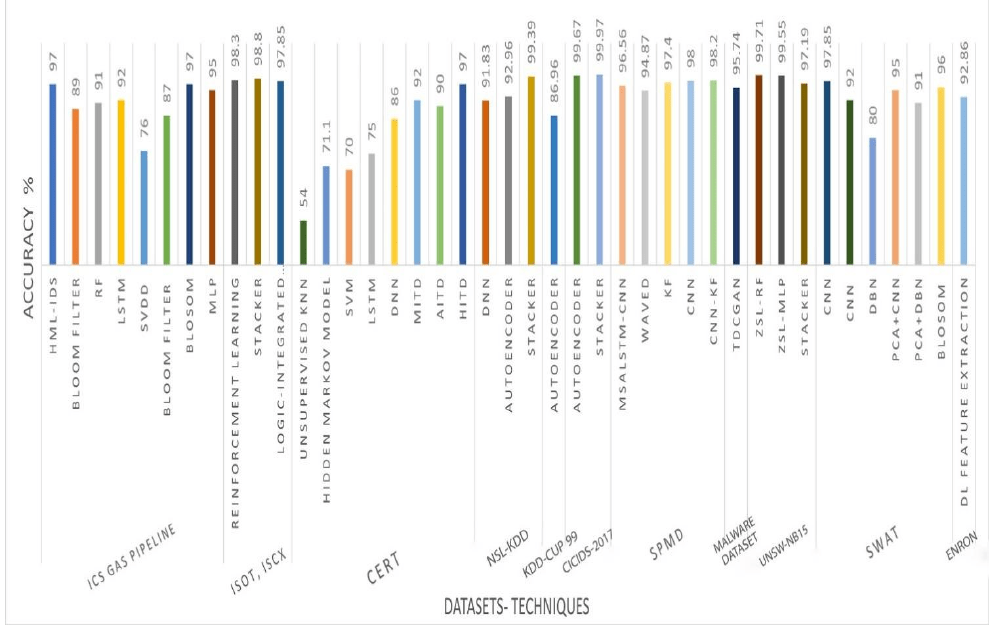
Figure 5. The accuracy of the compared techniques on different datasets.